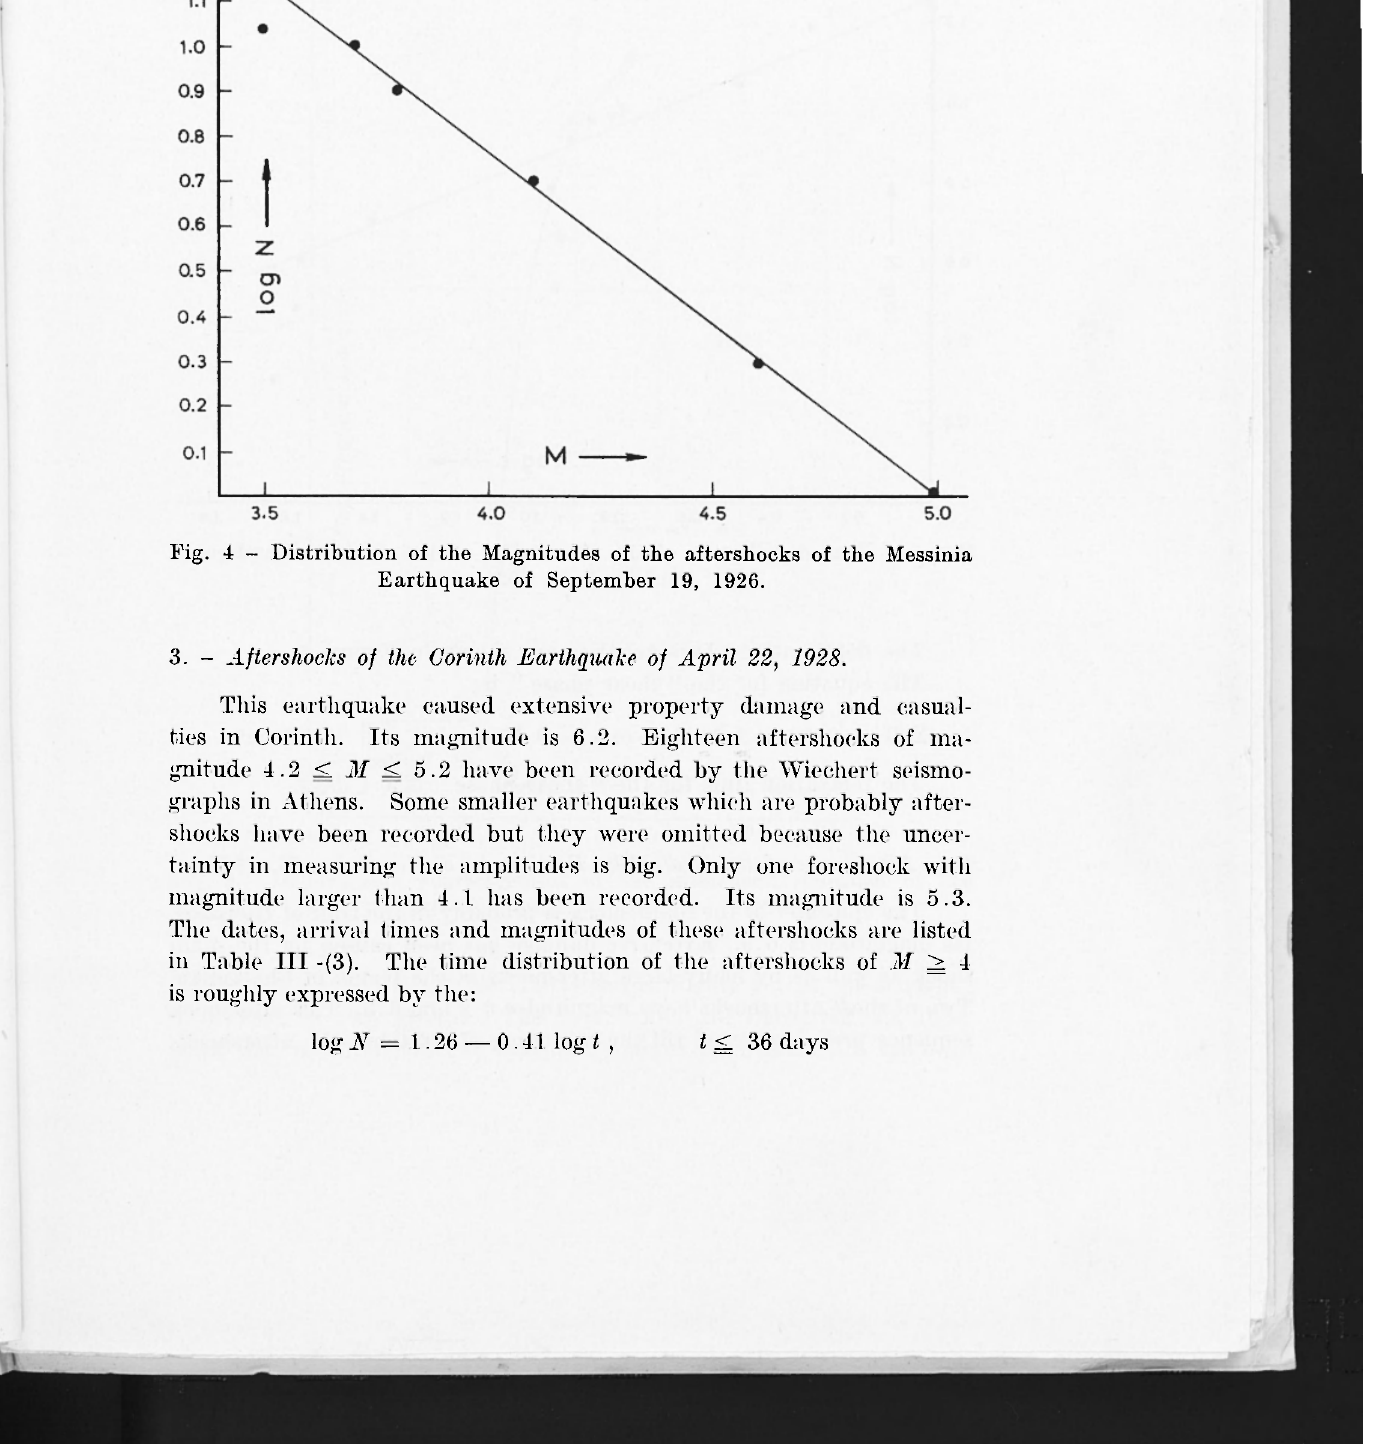
Fig. 4 - Distribution of the Magnitudes of the aftershocks of the Messinia Earthquake of September 19, 1926.